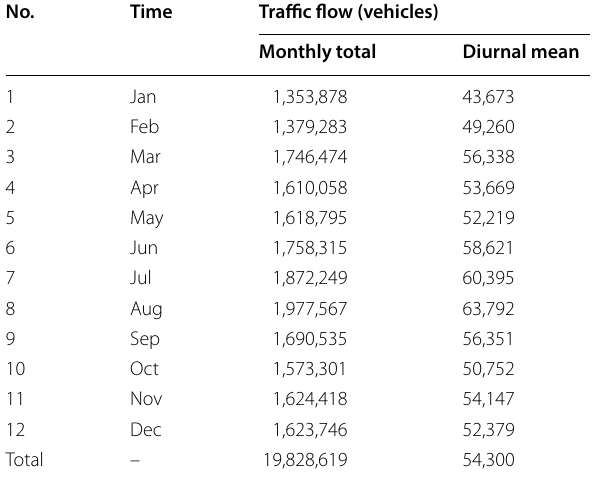
Table 2 Monthly distribution of traffic flow in 2018, after the total hour-by-hour detector of total vehicles in the study area